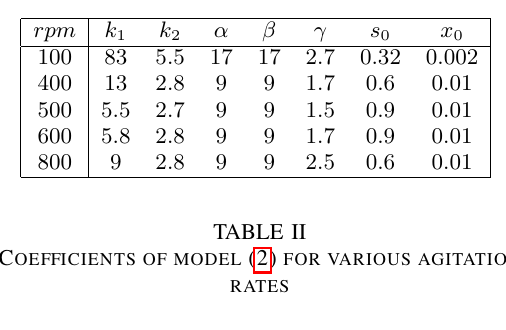
Fig. 5. Solution of model (2), 500 rpm